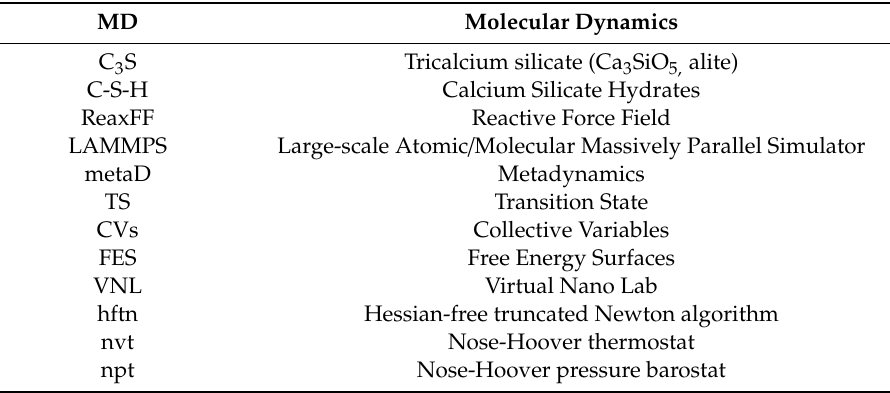
Table A2. List of